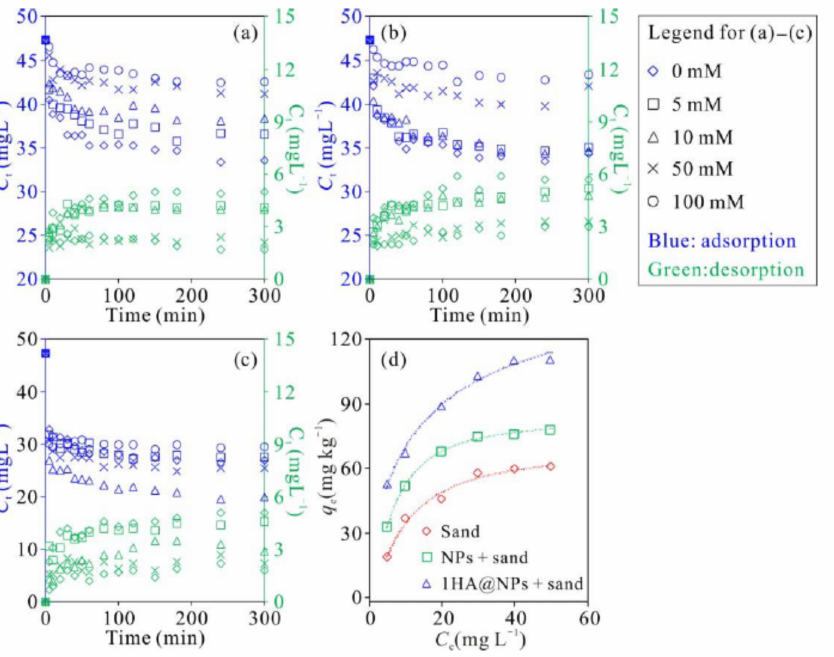
Figure 5. The adsorption and desorption of Cu 2+ on ( a ) pure sand ( b ) NPs + sand ( c ) 1HA @NPs + sand at different IS values; ( d ) Adsorption isotherms of Cu 2+ on the aforementioned mediums, and the dotted lines were the Langmuir isotherm fitting